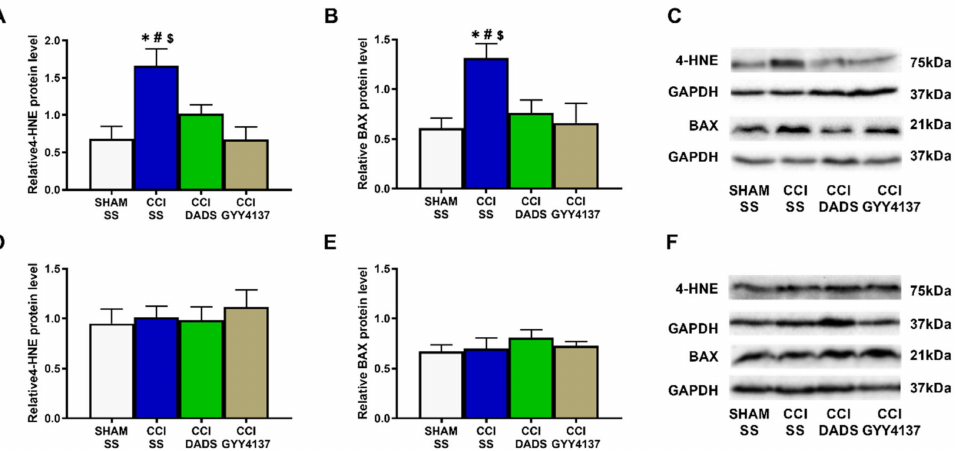
Figure 7. The influence of DADS and GYY4137 treatments on the expression of 4-HNE and BAX in the MS and DRG of mice with neuropathic pain. In the MS, both treatments regularized the overexpression of 4-HNE ( A ) and BAX ( B ). No changes in the expression of 4-HNE ( D ) or BAX ( E ) were detected in the DRG. Sham-operated (SHAM) mice treated with SS were used as control groups. 4-HNE and BAX are expressed relative to GAPDH levels. Blots for 4-HNE and BAX in the MS ( C ) and DRG ( F ) are presented. In all pictures, * symbolizes significant changes vs. SHAM-animals treated with SS; # vs. CCI-mice injected with DADS; and $ vs. CCI-mice injected with GYY4137 ( p < 0.05; one-way ANOVA followed by Tukey test). Each column represents the mean, and vertical bars indicate SEM ( n = 3